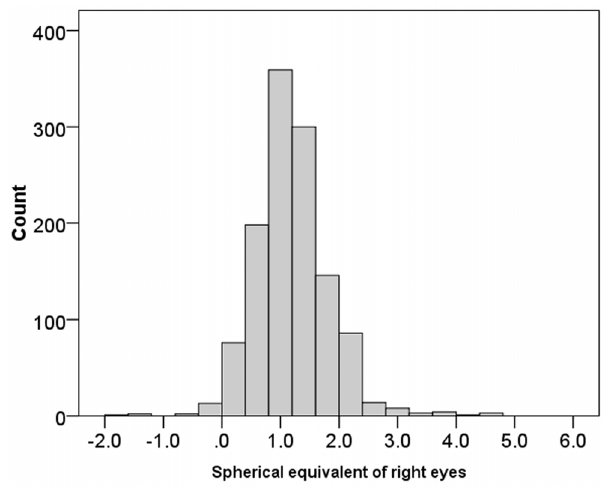
Figure 2. Distribution of season of birth.